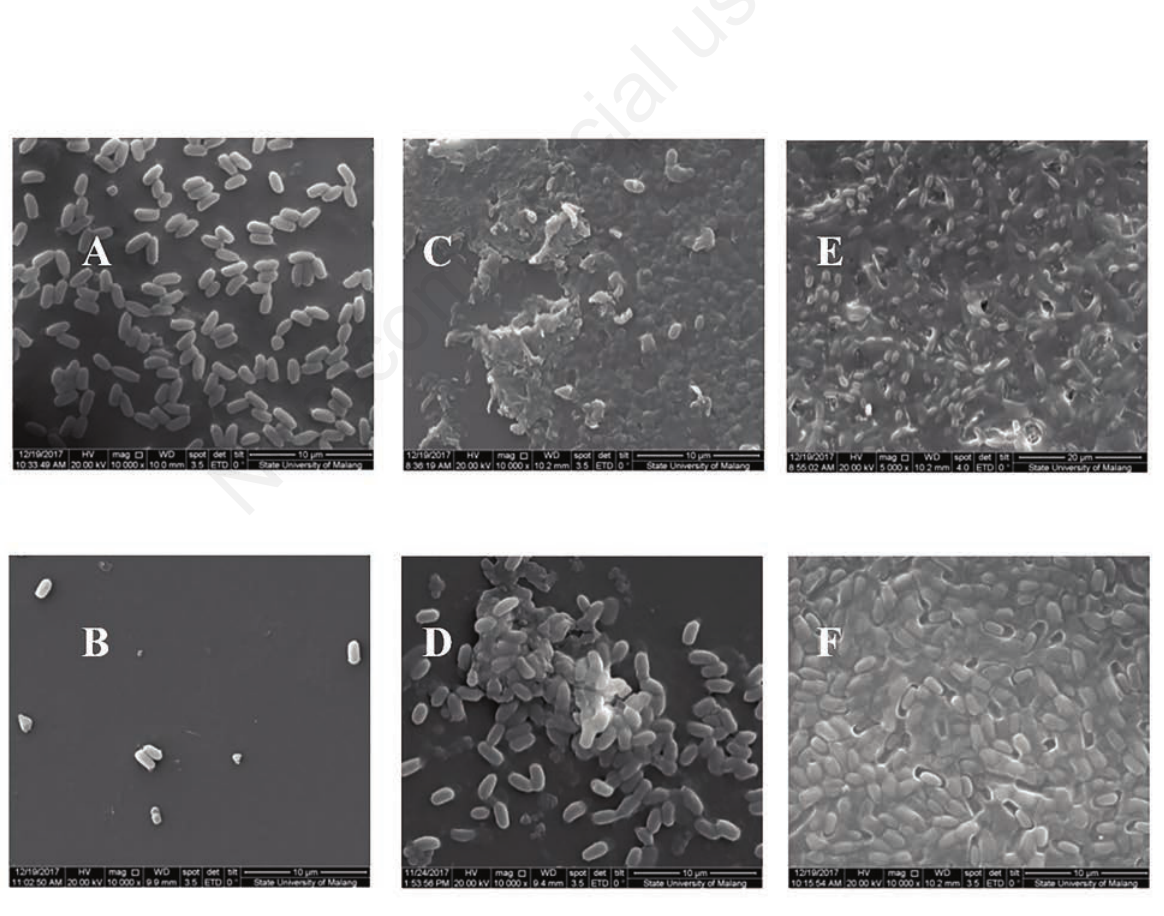
Figure 4. The results of SEM analysis at (a) 0 hour age biofilm control group (b) 0 hour age biofilm treatment group (c) 24 hour age biofilm control group (d) 24 hour age biofilm treatment group (e) 48 hour age biofilm control group (f) ) 48-hour-old biofilm treat- ment